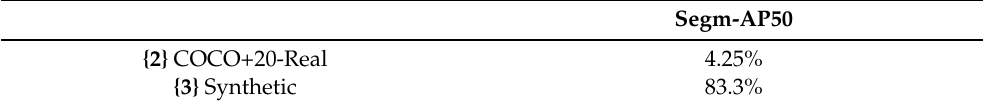
Table 3. Segm-AP50 results comparing {2} and {3} .